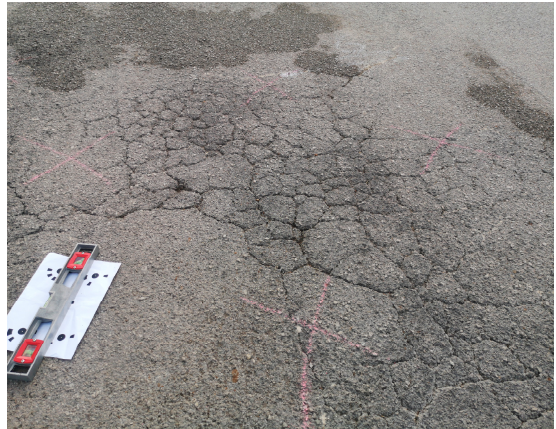
Figure 6. Distressed section 3.